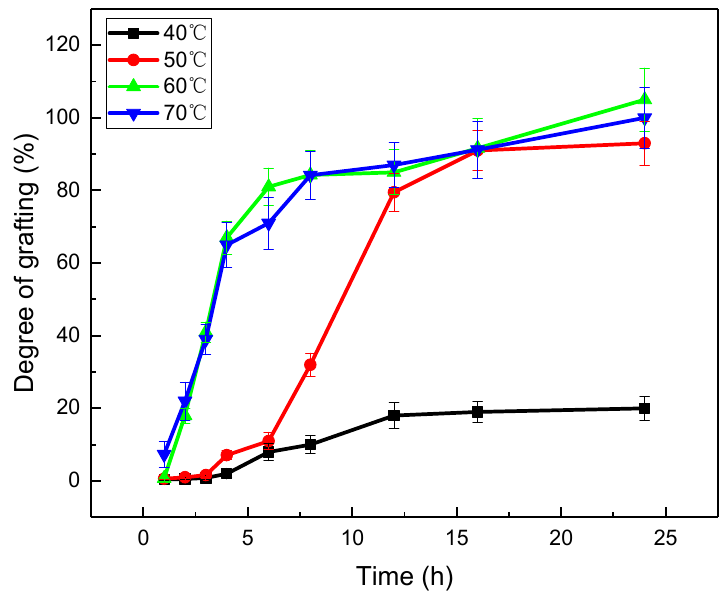
Figure 3. The degree of grafting of AAm versus the reaction time in the comparison of the reaction temperature (AAm was grafted in 25% aqueous solution, and the absorbed dose of the PP sheets was 200 kGy).